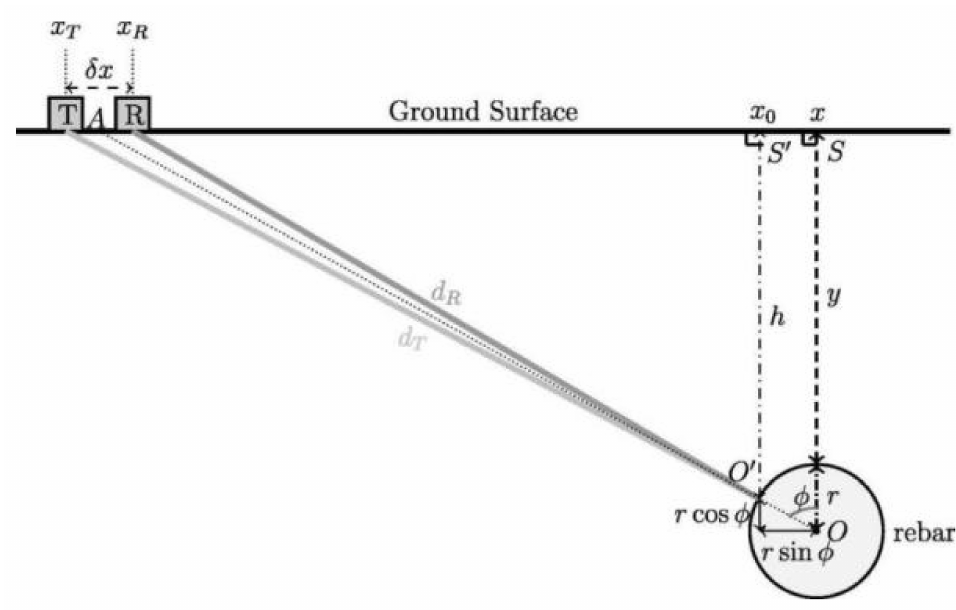
Figure 15. Geometry for cylinder detection using ground-coupled common-offset GPR antennas. The cylinder size is exaggerated for clarity